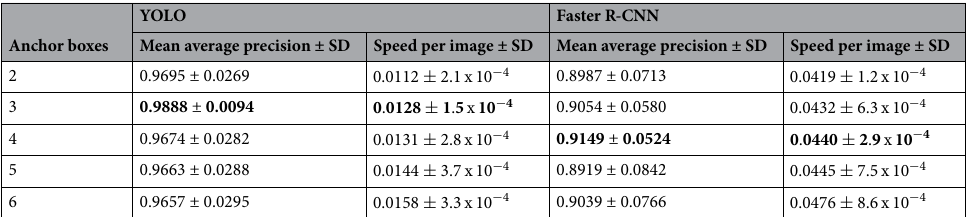
Table 1. The mean average precision (mAP) ± standard deviation (SD) and the detection (inference) speed/ image ± standard deviation (SD) for YOLO and Faster R-CNN detectors across all proposed anchor boxes. The mean speed was calculated/averaged across 1,000 selected